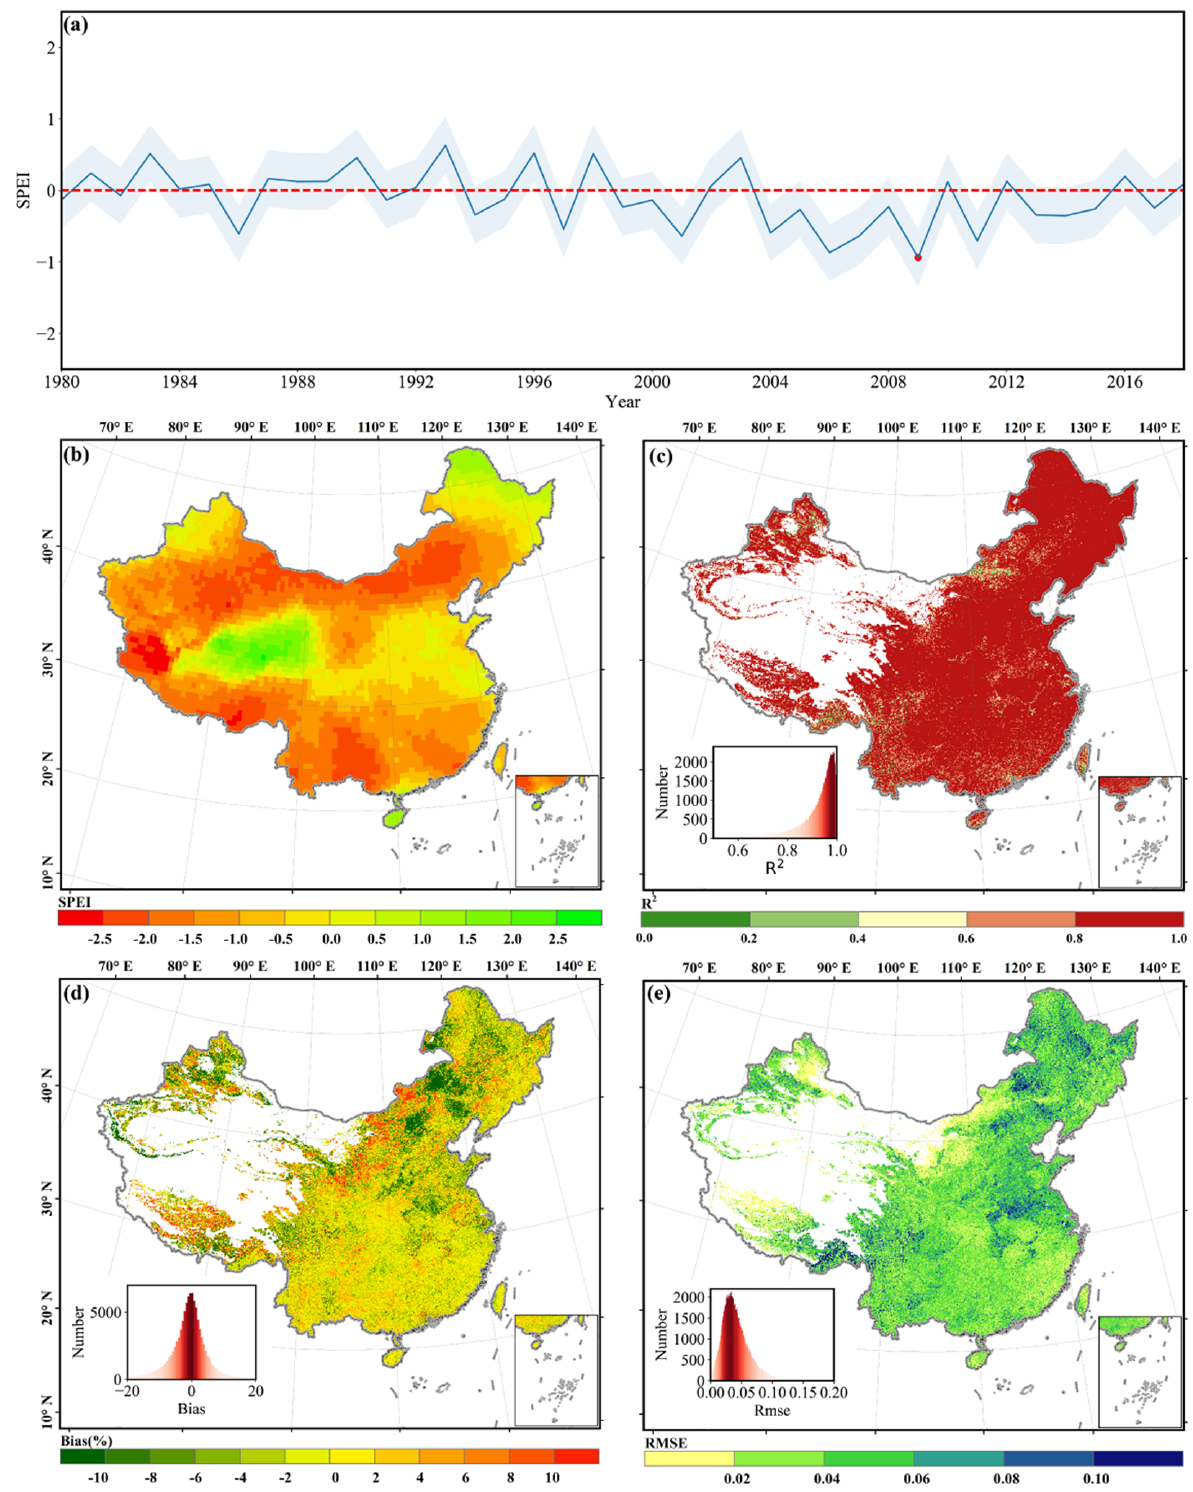
Figure 4 . Model performance during the drought year 2009 showing ( a ) the temporal evolution of drought in China from 1980 to 2018 based on the standardized precipitation evapotranspiration index (SPEI; negative values indicate drought conditions) and the spatial distribution of ( b ) SPEI, ( c ) R 2 , ( d ) bias, and ( e ) RMSE between the predicted and satellite-derived monthly NDVI in 2009.